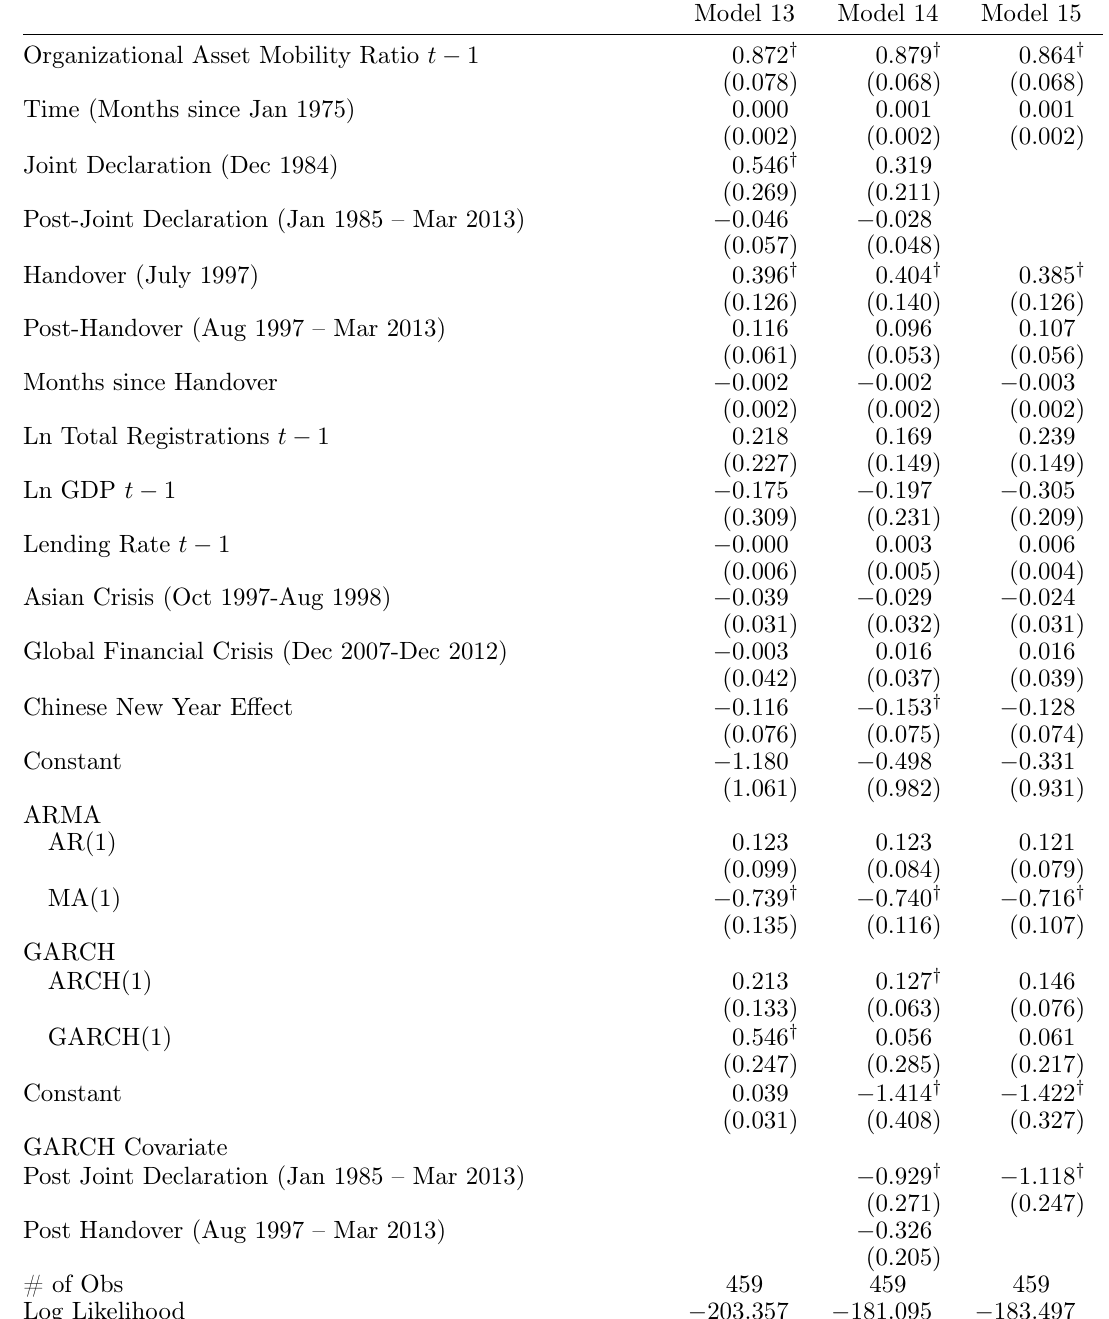
Table 4: GARCH Estimates of Effects of Handover on Organizational Asset Mobility